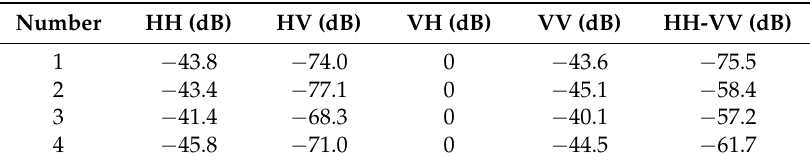
Table 4. Amplitude of the PARC scattering